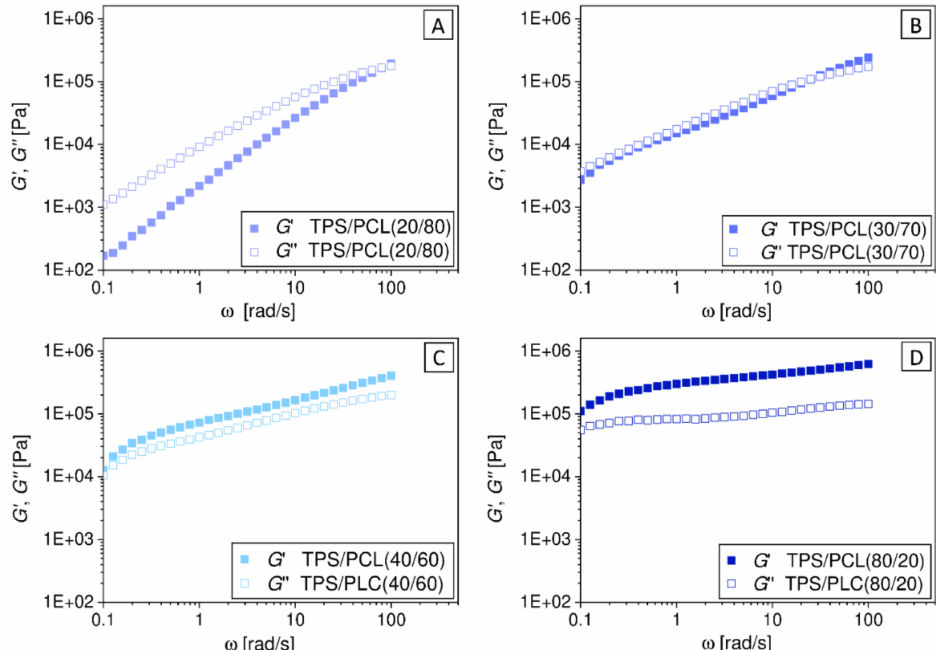
Figure A3. Selected examples of the frequency-dependence of storage shear modulus G (cid:48) and of the loss shear modulus G (cid:48)(cid:48) , as observed in oscillatory rheological investigations carried out at 120 ◦ C with TPS/PCL blends; the examples demonstrate the different degree of liquid-like and solid-like character for the blends: ( A ) TPS/PCL (20/80); ( B ) TPS/PCL (30/70); ( C ) TPS/PCL (40/60); and ( D ) TPS/PCL